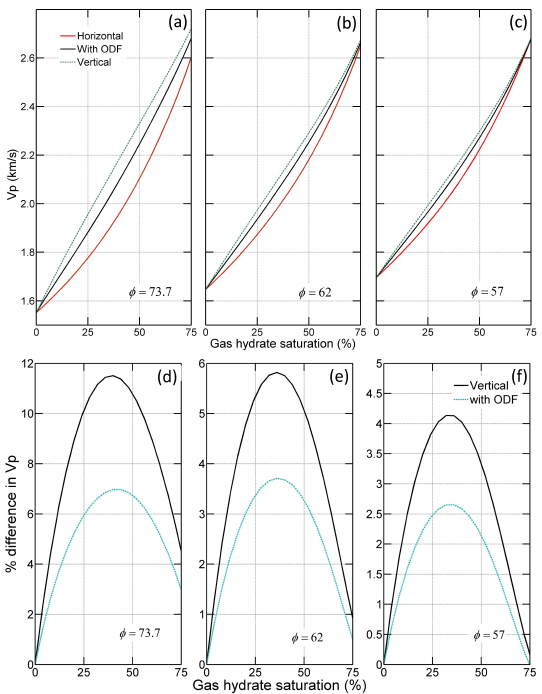
Figure 3. (a to c) Variations of V P with hydrate saturation in fractures with three porosities and aligned in horizontal, vertical and preferably oriented in vertical direction with ODF. (d to f) Percent difference in calculated V P for purely vertical and fractures with ODF with respect to horizontal fractures.